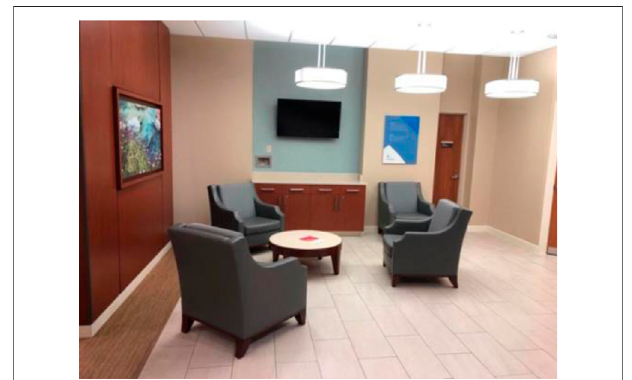
FIGURE8| Waitingarea:HospitalinCarmel,Indiana(2019),photograph by Lisann Good-Burton.